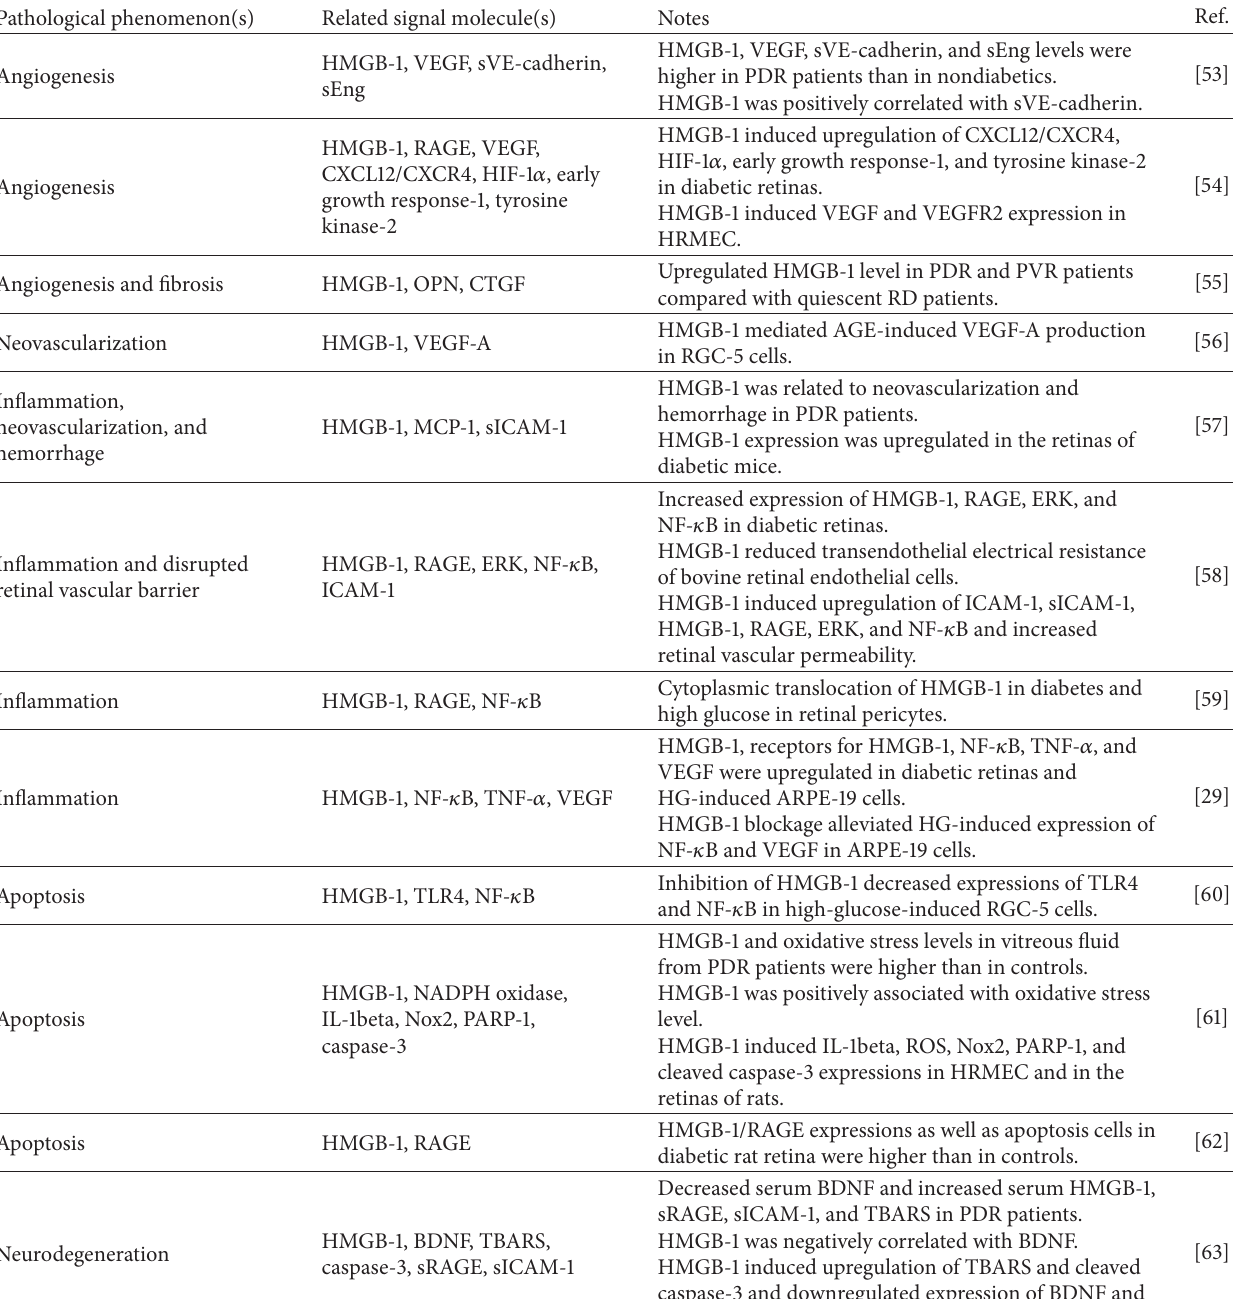
Table 3: HMGB-1 in DR (diabetic